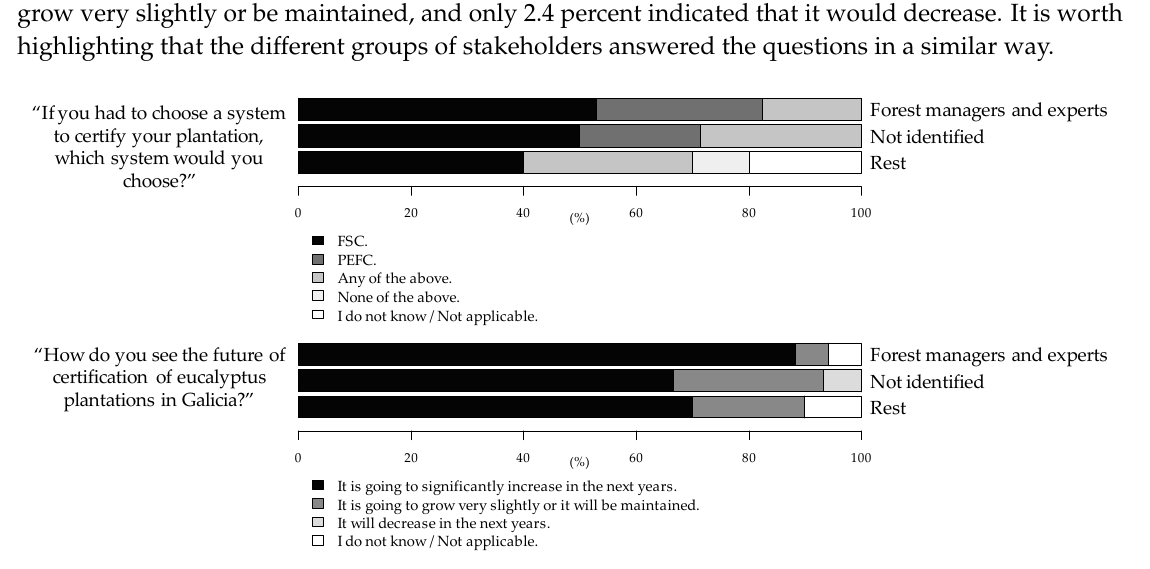
Figure 3. Stakeholder’s preference for forest certification system and its future ( n = 41). Stakeholders were classified in three groups: Forest managers and experts ( n = 17), stakeholders that did not want to identify themselves (Not identified, n = 14) and other groups (Rest, n = 10).